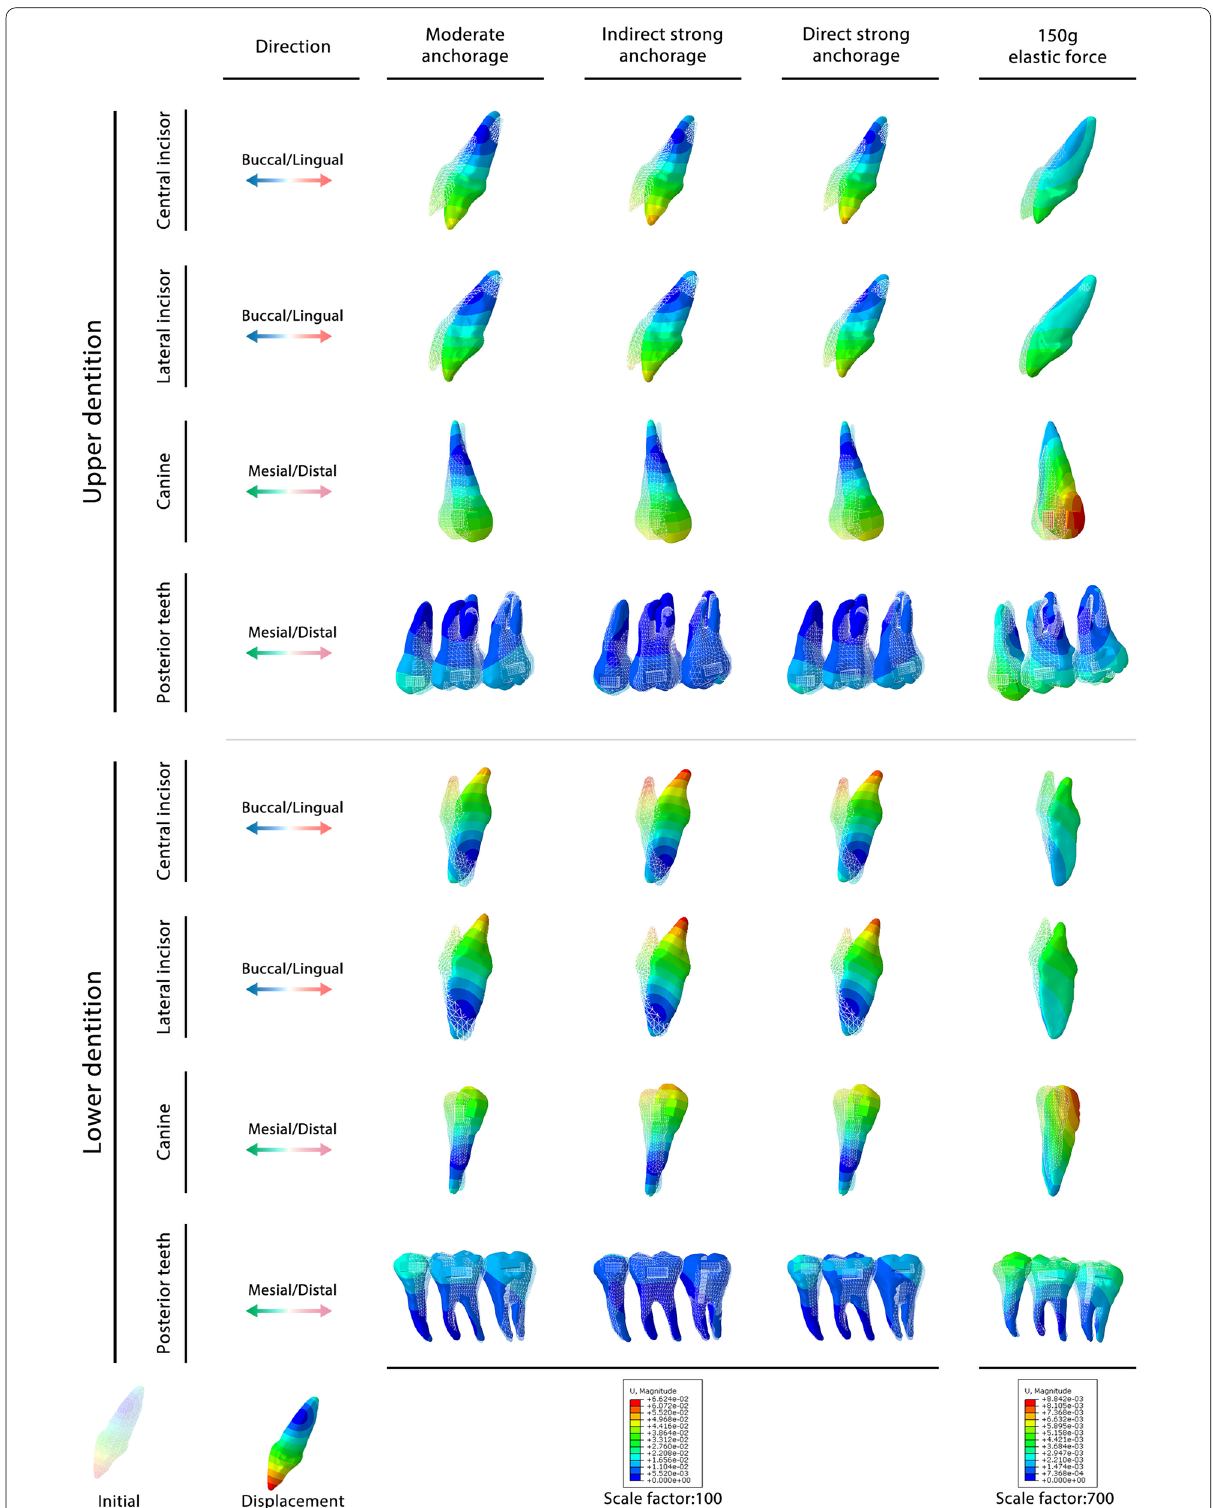
Fig. 5 Tipping movement tendency of the bimaxillary teeth under different anchorage control and elastic force. 1, central incisors; 2, lateral incisors; 3, canines; 5, second premolar; 6, first molar; 7, second